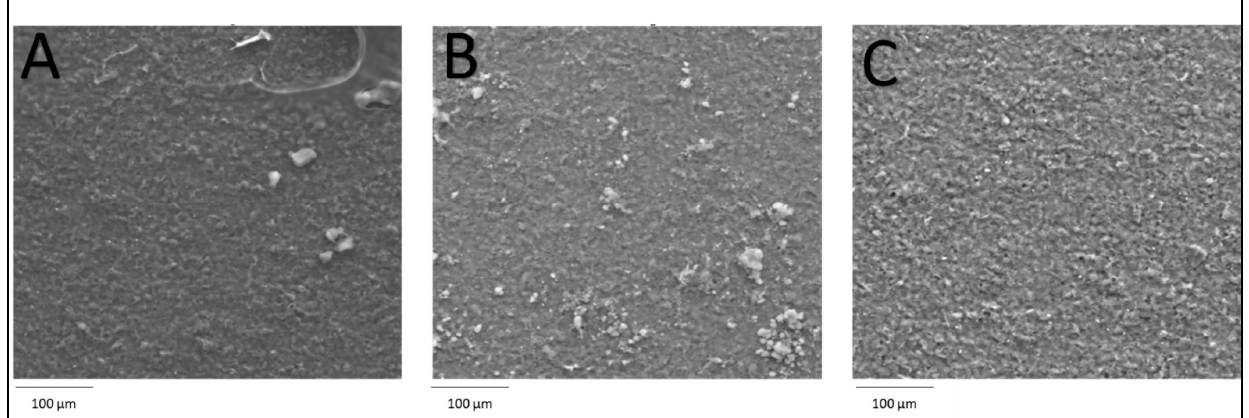
Figure 4. SEM images of unmodified electrode ( A ), C_Hal/Nafion/SPCE ( B ) and MWCNTs/C_Hal/Nafion/SPCE ( C ).